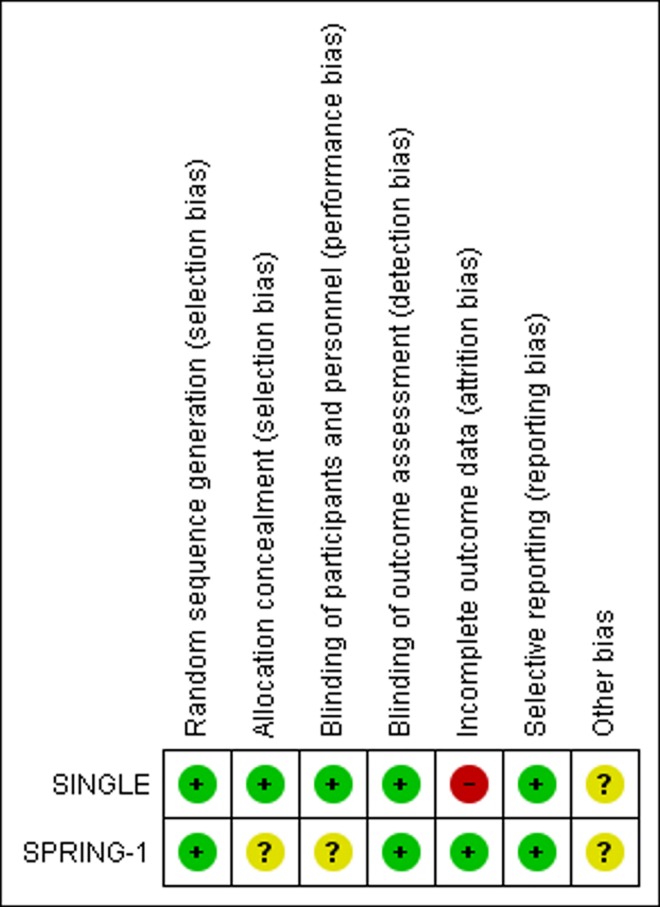
Risk of bias.Review authors' judgments about each risk of bias item for included studies.